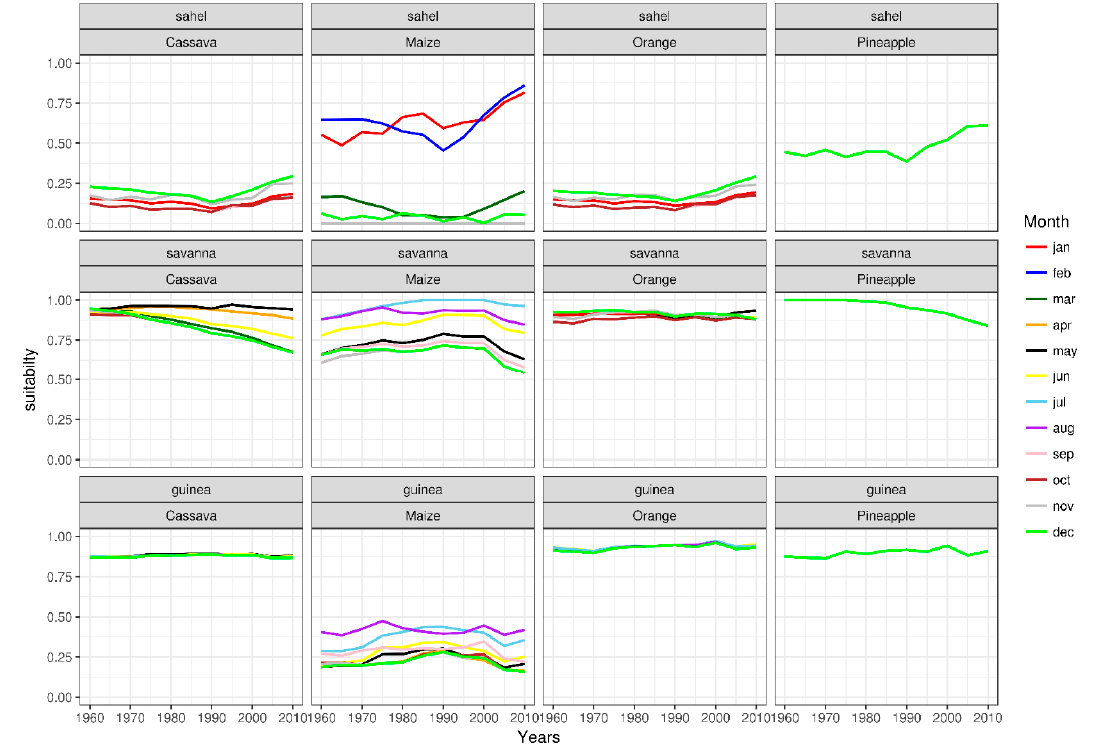
Figure 6. Ensemble crop suitability plots in the past climate (1960–2010) for cassava, maize, orange, and